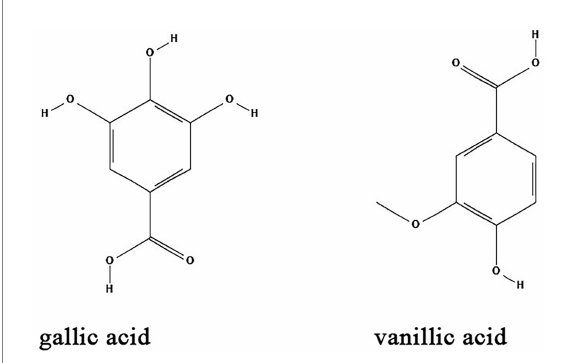
FIGURE 5 Chemical structures of the different organic acids that inhibit biofilm formation via QS. ChemDraw software has been utilized to draw the chemical structures of the